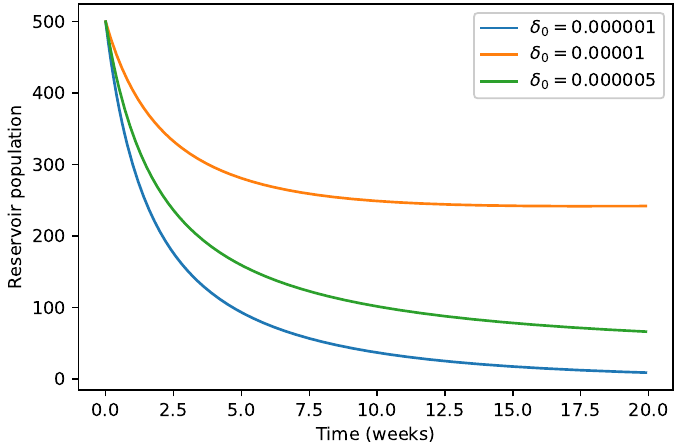
Figure 6. Variation of animals population with respect to δ 0 .